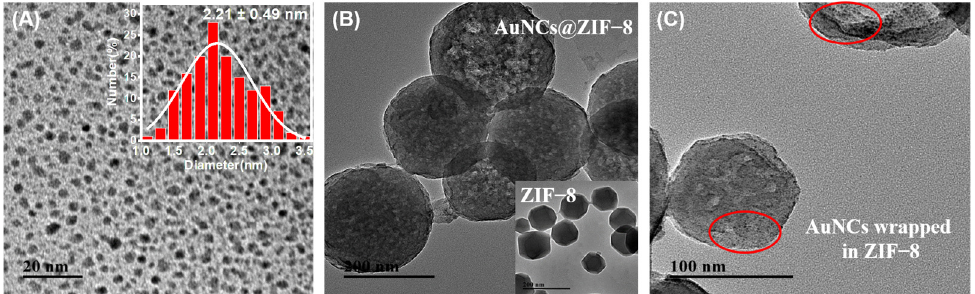
Figure 1. TEM morphology of ( A ) as-prepared GSH-AuNCs (insert size distribution of as-prepared GSH-AuNCs ) , ( B ) free ZIF-8 and AuNCs@ZIF-8 nanoparticles and ( C ) the AuNCs wrapped in ZIF-8 which were marked in red circles.